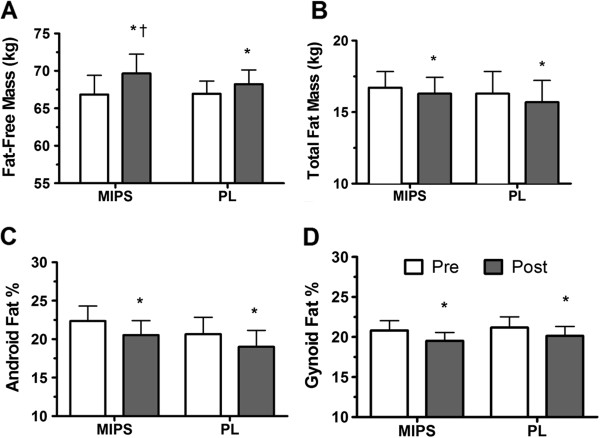
Body composition pre and post six weeks of supplementation and resistance training. A) fat-free mass, B) total fat mass C) android fat percent, and D) gynoid fat percent before and after six weeks of resistance training and supplementation with a multi-ingredient performance supplement (MIPS) or a carbohydrate Placebo pre- and post-exercise in resistance-trained men. White bars, pre-testing; Dark bars, post-testing. *, P < 0.05 compared to baseline. †, P < 0.05 compared to Placebo at the same time point.